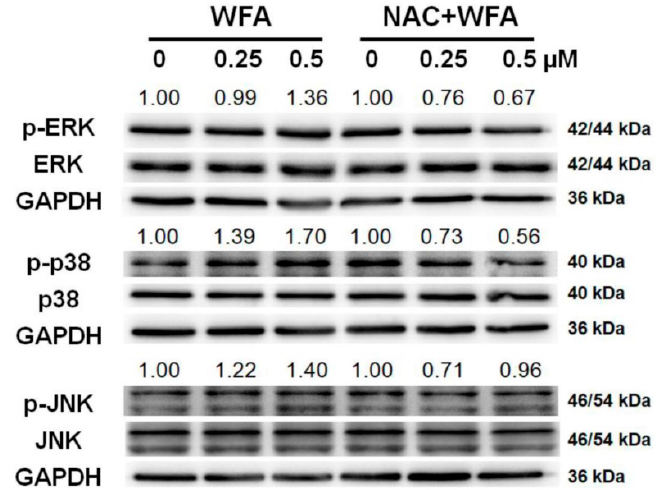
Figure 7. MAPK changes of low concentrations of WFA in oral cancer cells. Ca9-22 cells were pretreated with or without NAC (2 mM, 1 h) and post-treated with di ff erent concentrations of WFA for 24 h. ERK1 / 2, JNK1 / 2, p38, p-ERK1 / 2, p-JNK1 / 2, and p-p38 expressions were detected by Western blotting. The intensity ratio for each p-MAPK expression was adjusted to its matched MAPK and GAPDH intensities. Similar experiments were repeated 3 times.